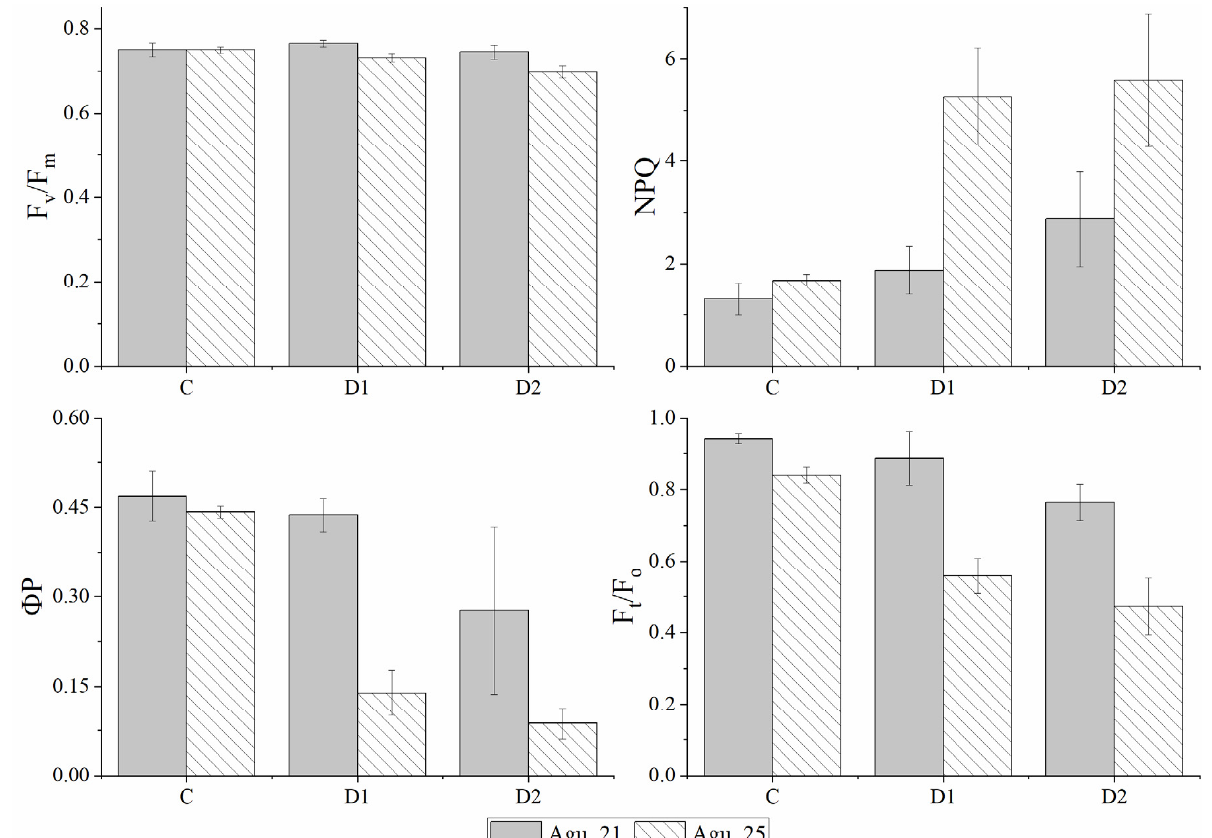
Figure 2. Differences in the key physiological parameters in the three water treatments (mean ± std, n = 3) measured on 21 August and 25 August. Four key parameters are the maximum quantum yield of PSII photochemistry ( F v / F m ), nonphotochemical quenching (NPQ), operating quantum yield of photochemistry in PSII ( Φ P ) , and steady state active fluorescence ( F t ) normalized to dark-adapted fluorescence ( F o ). C, D1 and D2 indicate the control, moderate drought, and severe drought respectively.